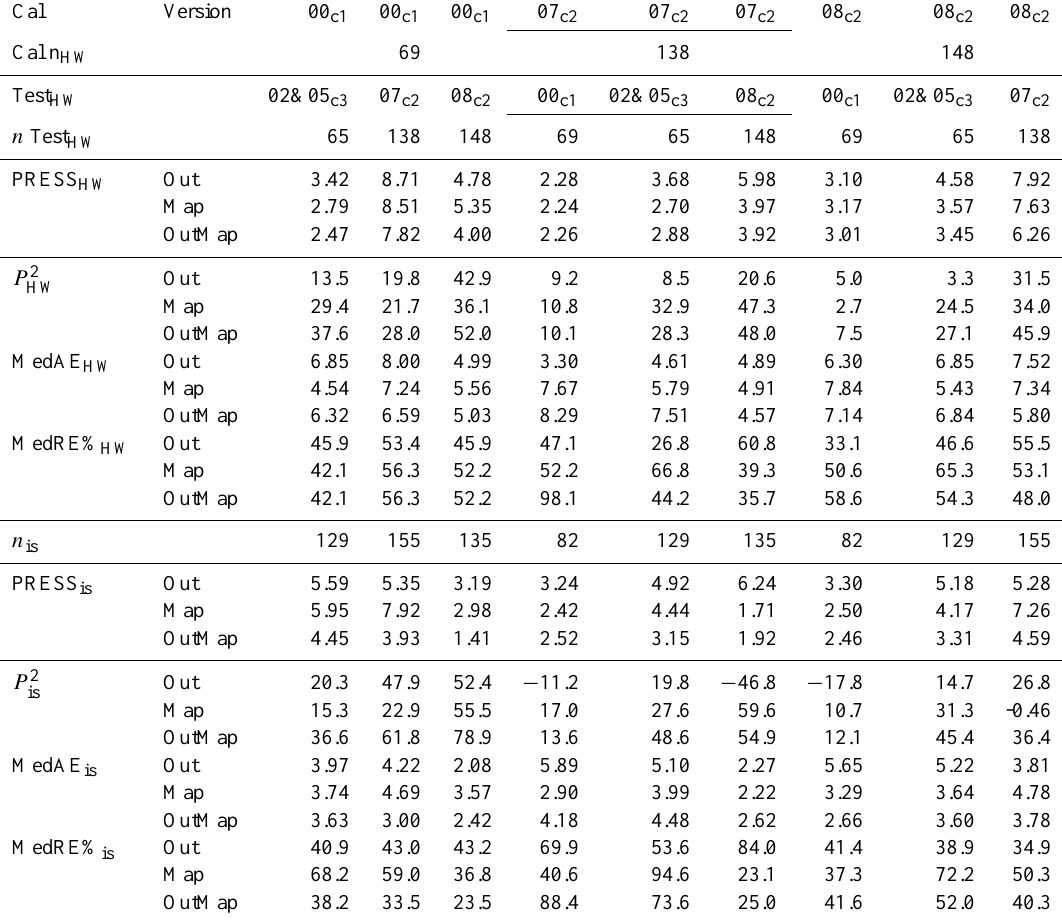
Table 5. Hierarchical linear mixed models (MM) results predicting headwater (HW) organic carbon (TOC) concentration in Log10. Cal is calibrated and 00, 07 and 08 refer to sampling year (2000, 2007 and 2008). The different coefficients are found in Table 4. Each calibration has three versions (intercept is always included): Out, Map and OutMap. The Out version includes OutletTOC, the Map version includes the map information, while OutMap includes both OutletTOC and map information. The prediction error sum of squares (PRESS) is the squared differences between observed and predicted values for the Y-data kept out of the model fitting in the Test sets (00 stands for year 2000, 02&05 for 2002 and 2005, 07 for 2007 and 08 for 2008). The bold values show the lowest PRESS of the three versions for that Test data, bold PRESS per test sites are the lowest for that version. Intermediate sites (is) stands for sites between headwaters and the river outlet. R 2 for predictions is called P 2 (similar to Q 2 for PLS): P 2 = 1-PRESS/TSS where TSS is the total sum of squared differences between modelled and the mean of observations. AE is absolute error and RE is relative error, calculated on TOC in mgL − 1